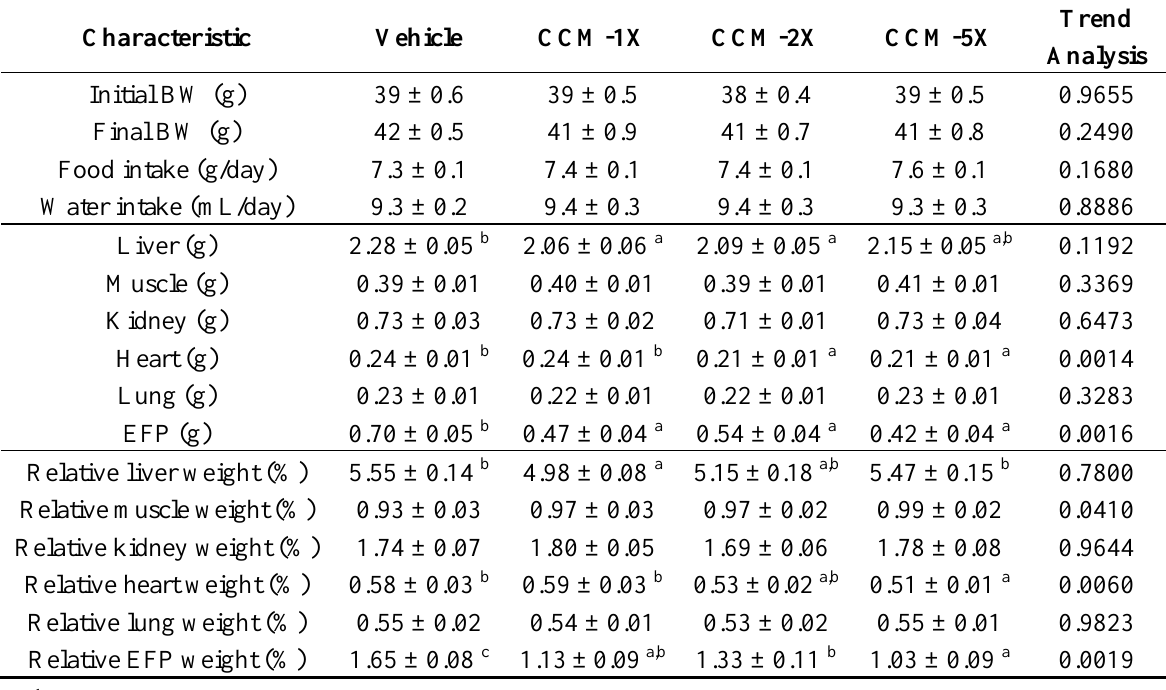
Table 1. General characteristics of the experimental groups with curcumin supplementation. Characteristic